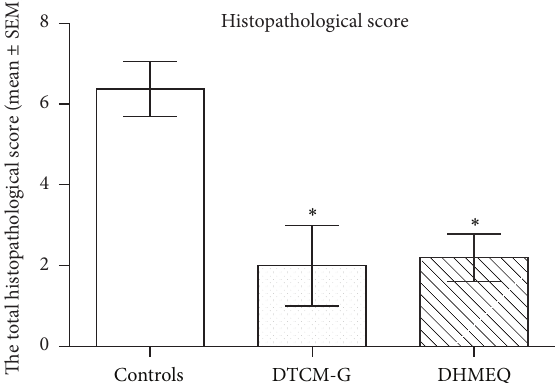
Figure 6: Total histopathological scores at the end-point of the experiment in the control, DTCM-G-treated, and DHMEQ-treated groups. ∗ 𝑃 < 0.05 versus